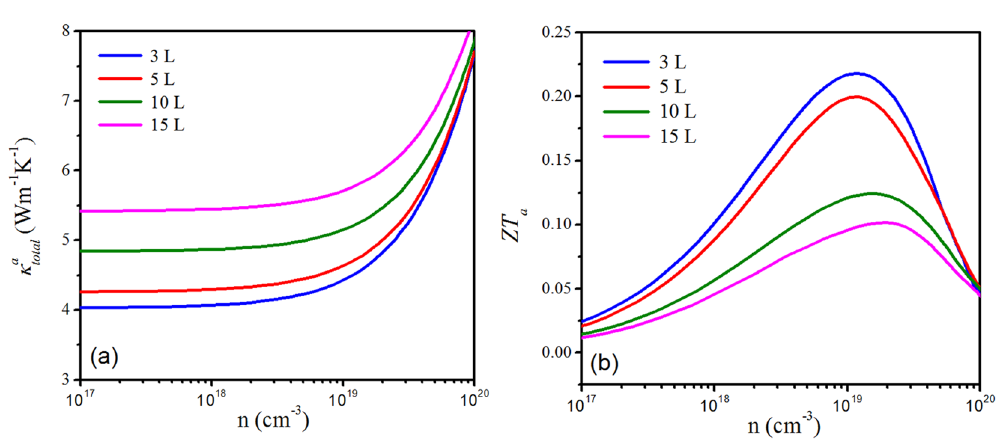
Figure 5. The total thermal conductivity ( a ) and ZT ( b ) value in a-b plane as a function of carrier concentration at room